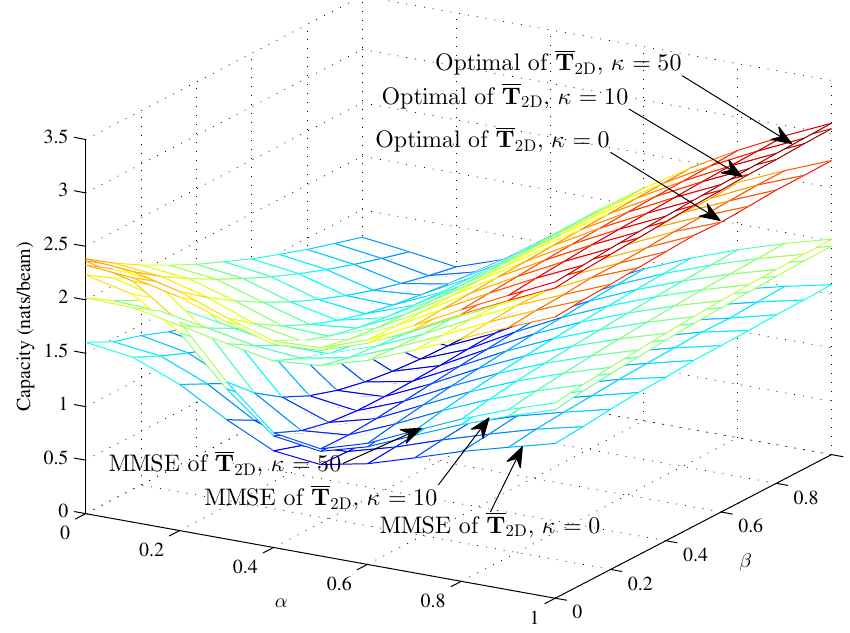
Figure 6. The optimal capacity and MMSE capacity of the hybrid 2D beams with γ = 10, L = 50 and M = 50 ( κ = 0, κ = 10 and κ = 50) versus α and β